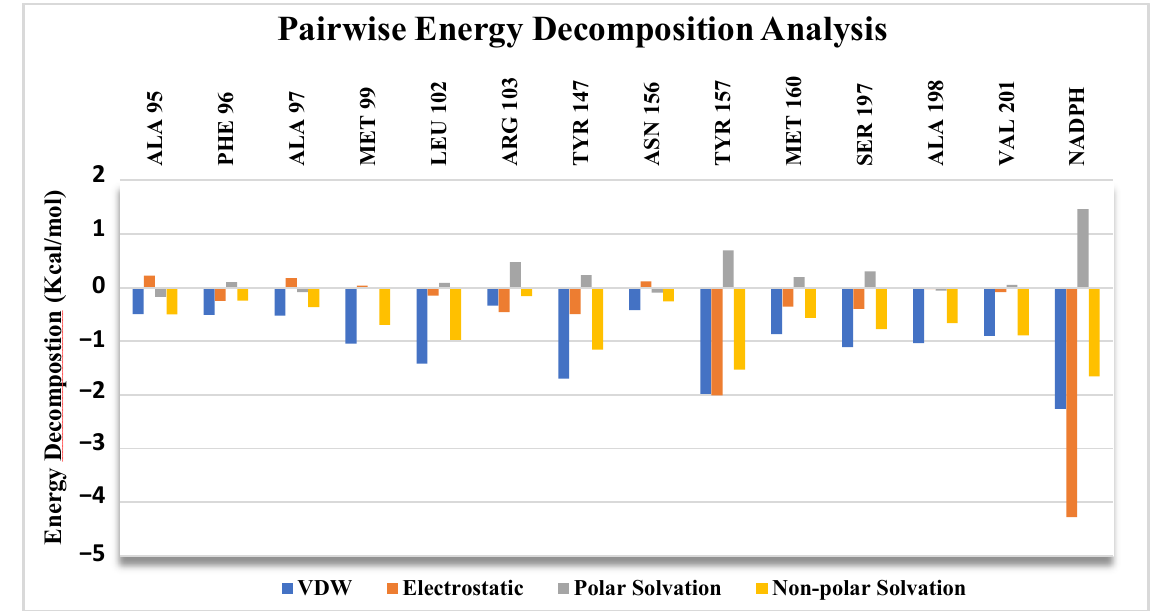
Figure 8. Pairwise energy decomposition for RK10. The highest contribution was seen with NADPH and the key residue Tyr 157.